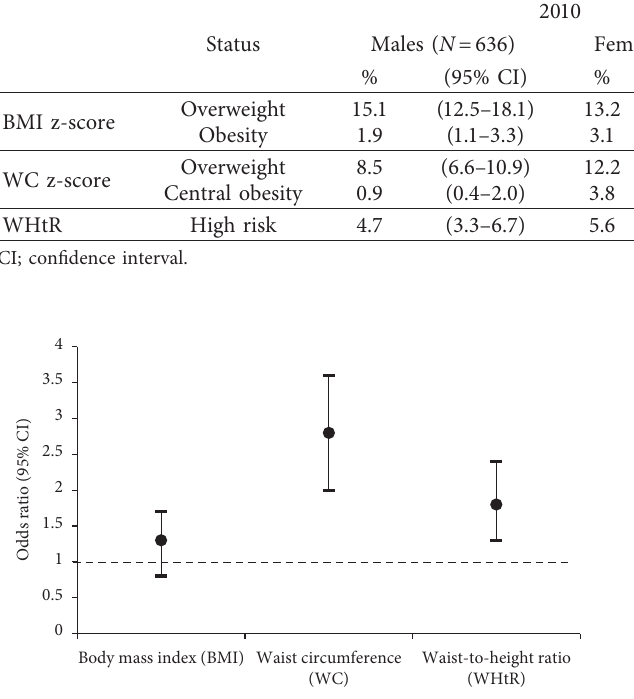
Figure 2: Odds of being BMI overweight/obese, central over- weight/obese (WC), and being at “high risk” (WHtR ≥ 0.5) in 2020 when compared to quartiles of height z-score was 126.7 cm, 131.1 cm, 137.4 cm,